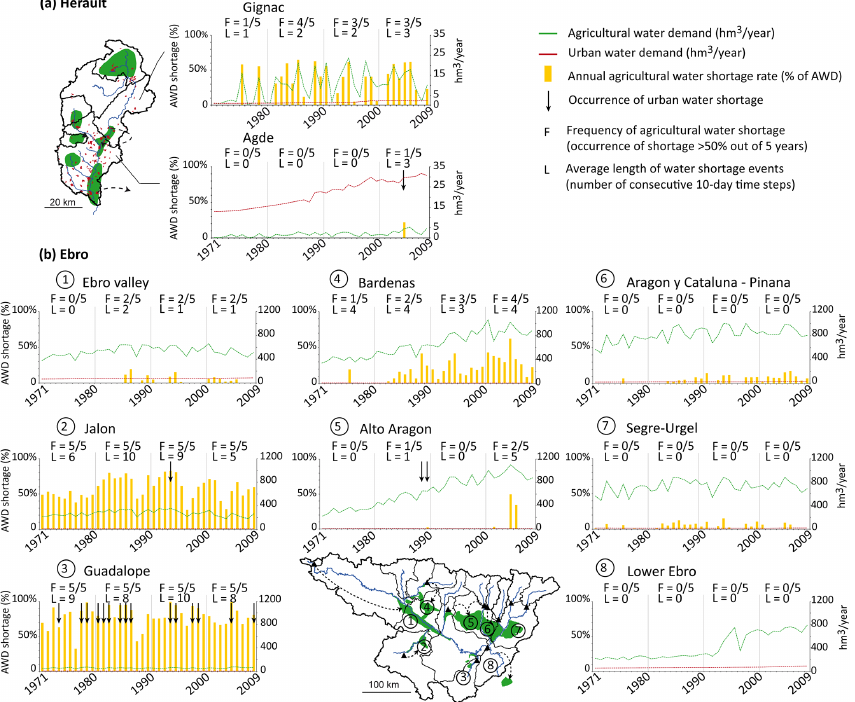
Figure 10. Frequency and intensity of agricultural and urban water shortage in the period 1971–2009 considering the spatial and temporal dynamics of water uses and hydro-climatic conditions (a) in the Hérault Basin and (b) in the Ebro